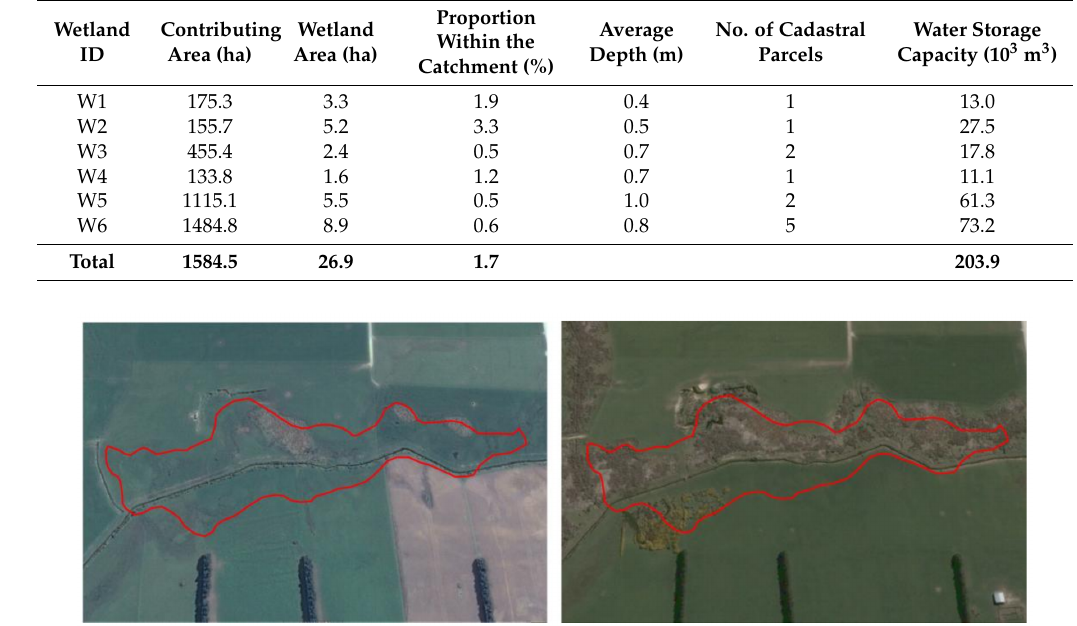
Figure 8. Potential wetland site W5 in 2003 and in 2015. The red line indicates the modelled potential wetland